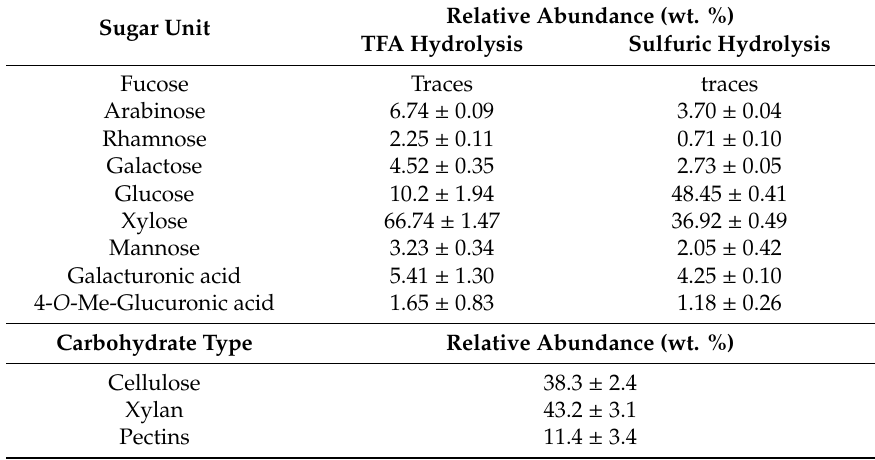
Table 1. Carbohydrate composition of PSP, calculated by TFA and sulfuric hydrolysis (n = 3, mean ± SD). Sugar